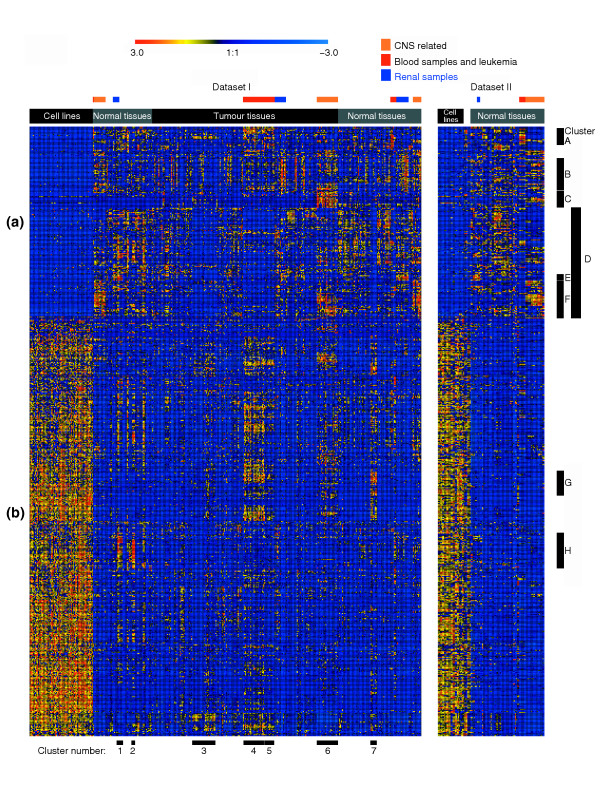
The gene-expression signature of in vitro growth. All genes found to be differentially expressed between cell lines and tissues across two dataset I and II (576 genes) were subject to hierarchical clustering (average linkage and Euclidean distance metric) using the Genesis software [43]. Before clustering, all genes were normalized to an average expression level of zero and a standard deviation of one (that is unit length). Above the cluster image, samples are labeled as cell lines, normal tissues and tumor tissues (except for the primary cultures and FACS-sorted cells in datasets II that were not annotated). (a) Top part of the cluster presents the genes found to be downregulated in vitro. These genes were not detected in vitro and were often only expressed in a subset of tissue samples. It is likely that these genes represent downregulated tissue markers from the respective tissues. (b) In contrast, genes found to be upregulated in vitro were highly expressed in all cell lines, while occasionally expressed in a few tissue samples. Specific clusters of genes in (a) and (b) are annotated on the right of the cluster image (clusters A to H). Specific groups of samples are annotated in color above the cluster image and by number below the cluster image (cluster numbers 1 to 7). Cluster number 1, kidney and liver samples; cluster number 2, lung and muscle; cluster number 3, lymphomas; cluster number 4, leukemias (ALL); cluster number 5, leukemias (AML); cluster number 6, CNS tumors (medullablastoma and glioblastoma); cluster number 7, germinal center cells.